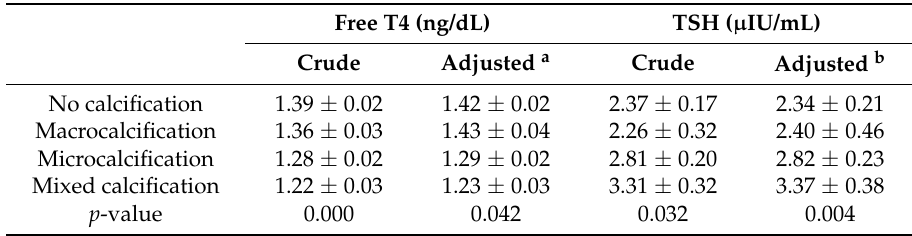
Table 4. Crude and adjusted mean free T4 and TSH concentrations according to the four calcification